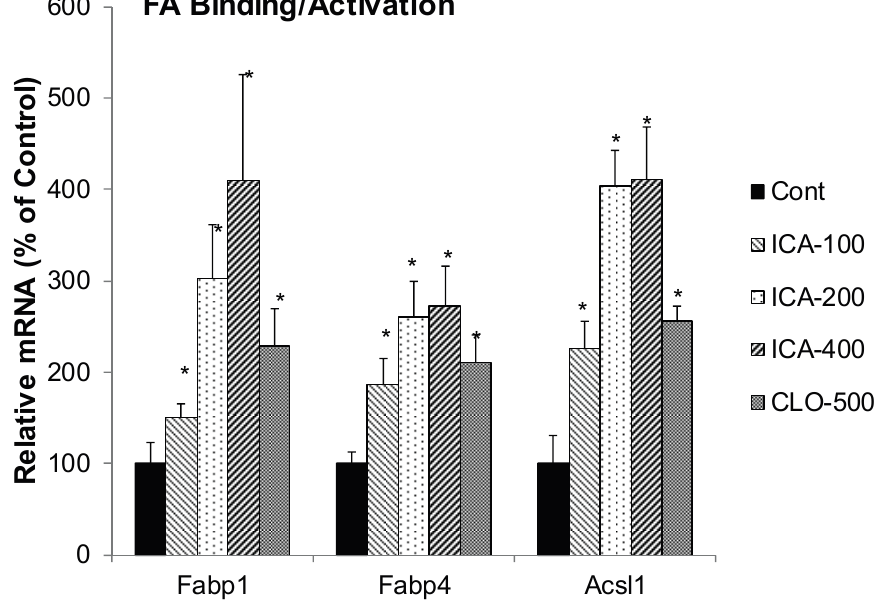
Figure 2. Effects of Icariin (ICA) on expression of fatty acid binding proteins and coactivators. Data are expressed as mean ± SEM (n = 5). * Significantly different from CMC-treated mice ( p <